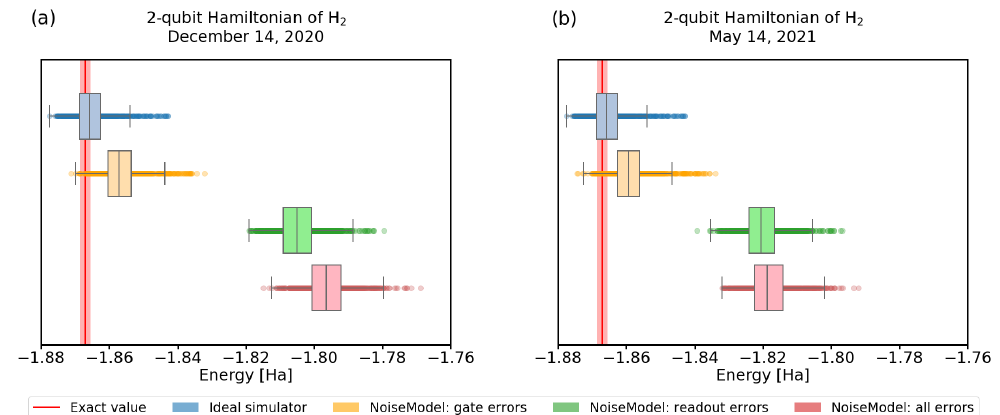
Figure 6. A comparison of VQE results with noise calibration from two different dates. We used quantum backend ibmq_santiago . All the other parameters in the simulation were kept the same, using 4096 shots and the R y R z variational ansatz. The red line represents the physical ground-state energy ( − 1.86712 Hartree) and the light-red background represents the chemical accuracy ( ± 0.0015 Hartree).